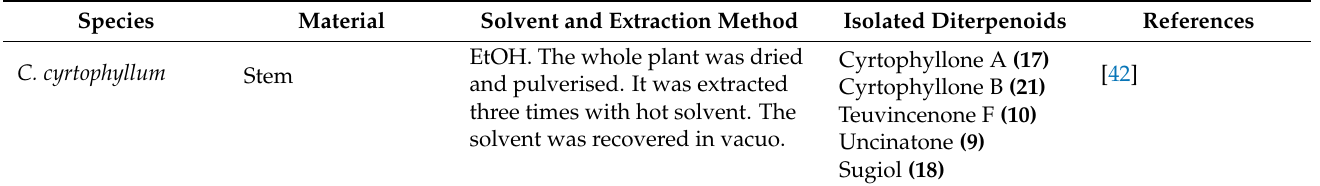
Table 3. The dichloromethane-methanolic root extract was found to contain ten abietane diterpenoids, with one being a new discovery: 12-hydroxy-8,12-abietadiene-3,11,14-trione (22) . The remaining nine diterpenes had previously been isolated from other plant materials: royleanone (23) , taxodione (24) , 6-deoxy-taxodione (25) (11-hydroxy-7,9(11),13-abietatrien- 12-one), sugiol (18) , ferruginol (26) , 6-hydroxysalvinolone (27) , 6,11,12,16-tetrahydroxy- 5,8,11,13-abietatetra-en-7-one (28) , uncinatone (9) and 11-hydroxy-8,11,13-abietatriene-12- O- β -xylopyranoside (29) [47]. Table 2. The diterpenoid extraction method and C. cyrtophyllum plant material for diterpenoid isolation. Species Material Solvent and Extraction Method Isolated Diterpenoids